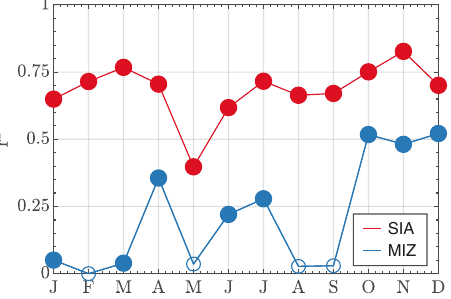
Fig. 2 Correlation between SIA/MIZF and GMT. Seasonal cycle of explained variance ( r 2 ) of SIA trends (red) or MIZF trends (blue) by annual GMT trends across all CLIVAR-LE and CMIP6-EME simulations. Solid circles are signi fi cant correlations ( p <